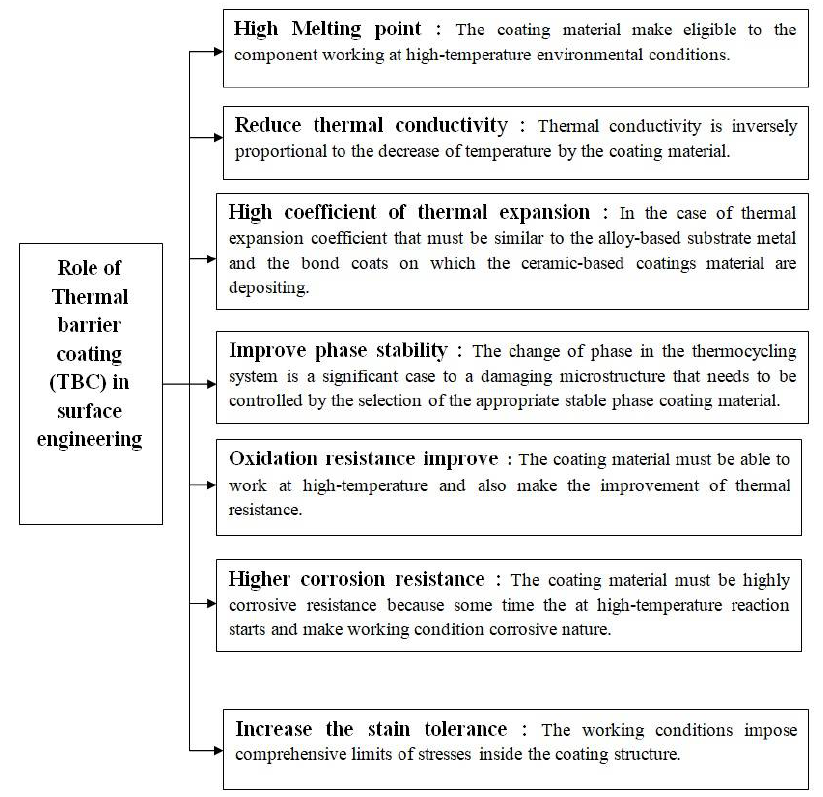
Figure 17. The importance and requirement of Thermal Barrier Coating (TBC) in surface engineer- ing